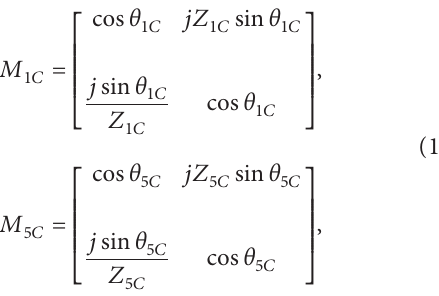
Figure 5: (a) The transmission coefficients ( S 21 ) of the proposed MW-BPF using a QC-SSIR with varied L 5 B values. (b) The reflection coefficients ( S 11 ) of the proposed MW-BPF using a QC-SSIR with varied L 5 B